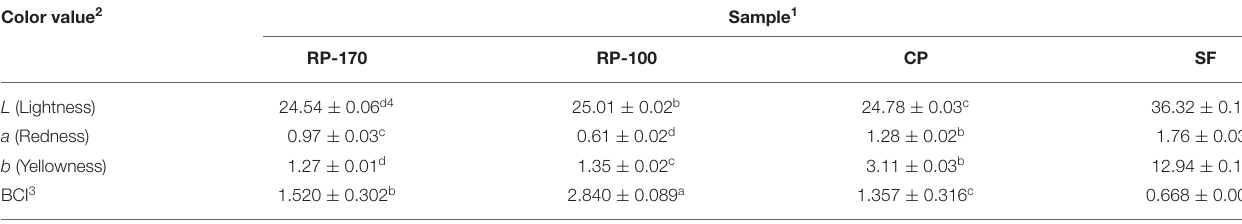
TABLE 3 | Color value and browning color intensity of lemon seed oils extracted using different methods. Color value 2